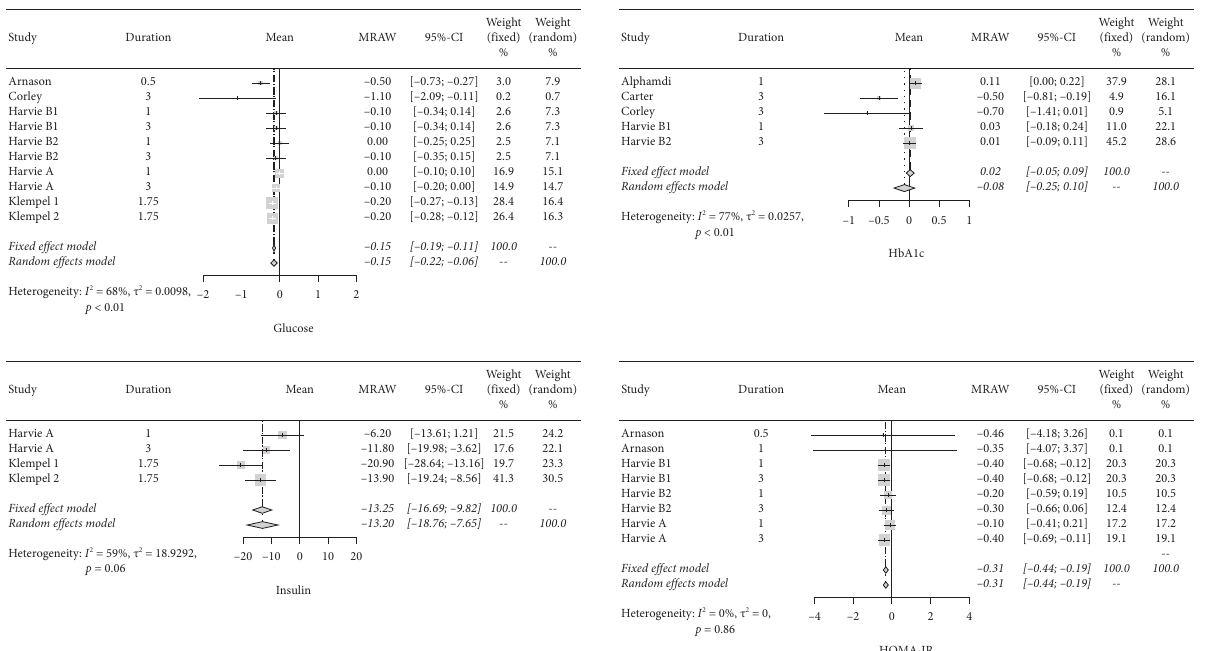
Fixed effect model Random effects model